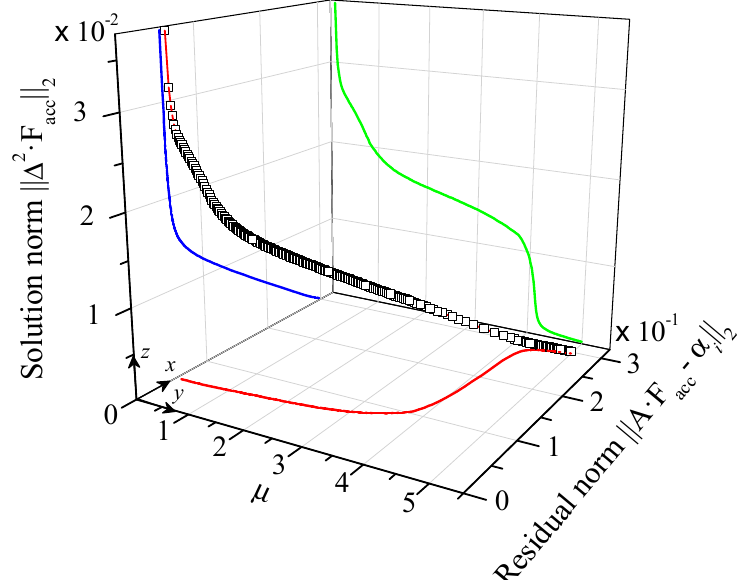
Figure 5. Three-dimensional visualization of the relation between the L-Curve (blue) and the different values of μ for an in-plane Fuchs-Sondheimer suppression function at T = 300 K for silicon measurements.